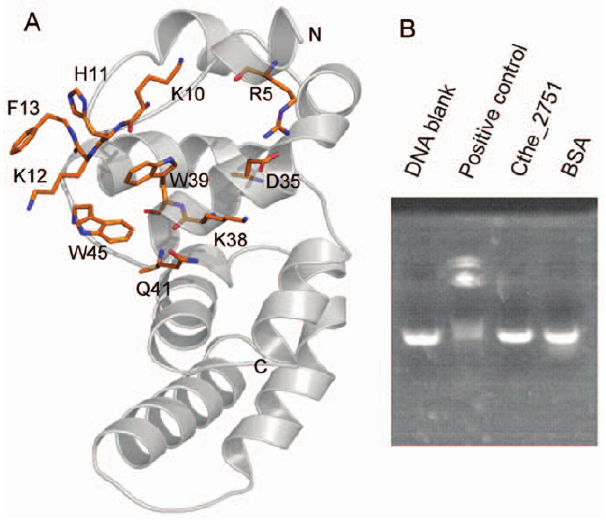
Figure 7. Functional analysis of Cthe_2751. (A) Cluster of aromatic and charged residues of Cthe_2751. N and C terminals are marked; Cthe_2751 is depicted as a cartoon, amino acids as sticks. (B) Nucleic acid binding ability of Cthe_2751 was tested in an EMSA assay. Cthe_2751 could not bind double stranded nucleic acids similar to bovine serum albumin (BSA) under the assay conditions. Lambda repressor protein was used as a positive control.